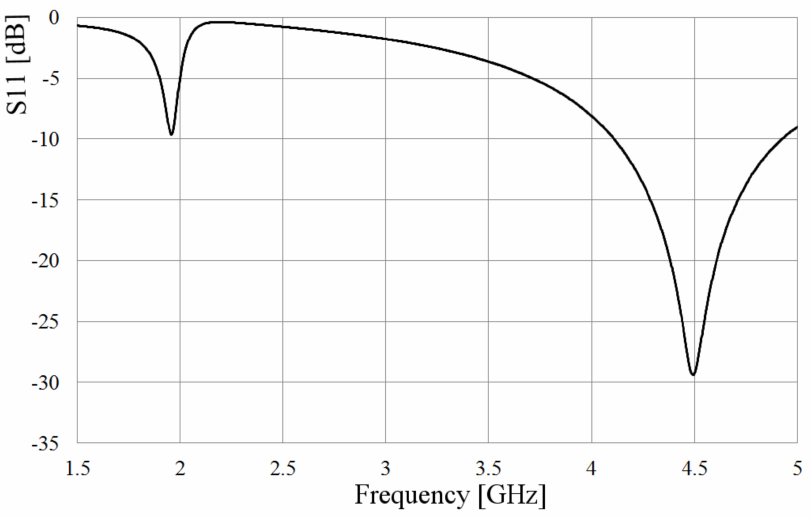
Figure 9. Simulated S11 parameter of the loop-slot